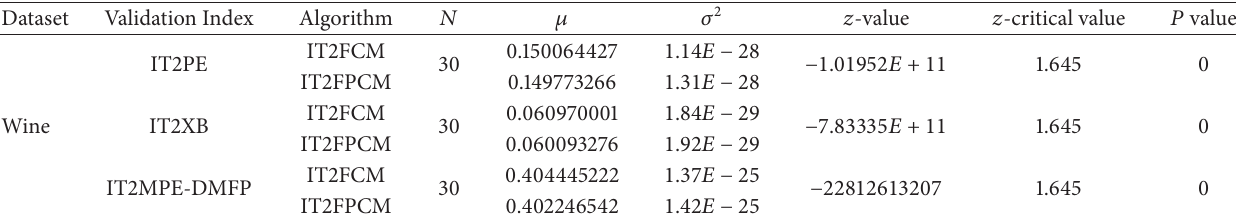
Table 8: Hypothesis test for IT2PE, IT2XB, and IT2MPE-DMFP indices of validation for the Wine dataset clustering.